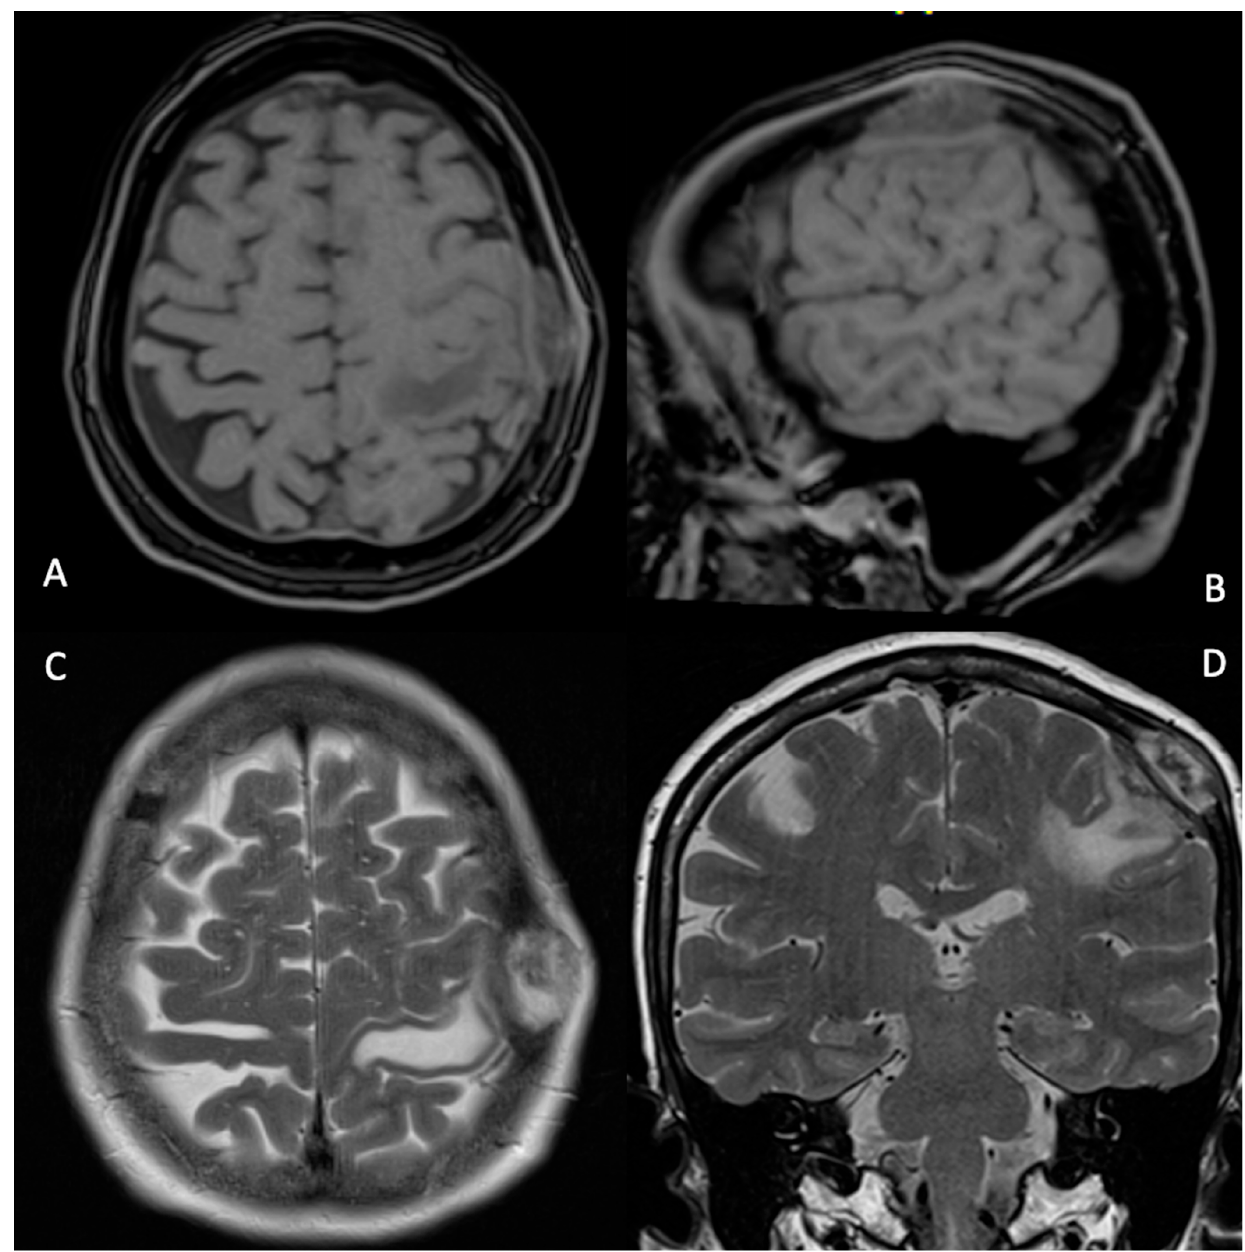
Figure 1. MRI ( A ) axial and ( B ) sagittal T1-weighted scans showing intra-calverian metastasis; ( C ) axial and ( D ) sagittal T2-weighted scans showing the lesion and the related edema in motor area.